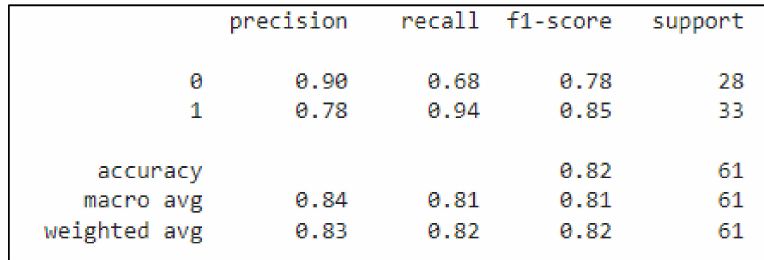
Figure 7. Classification report for the DL